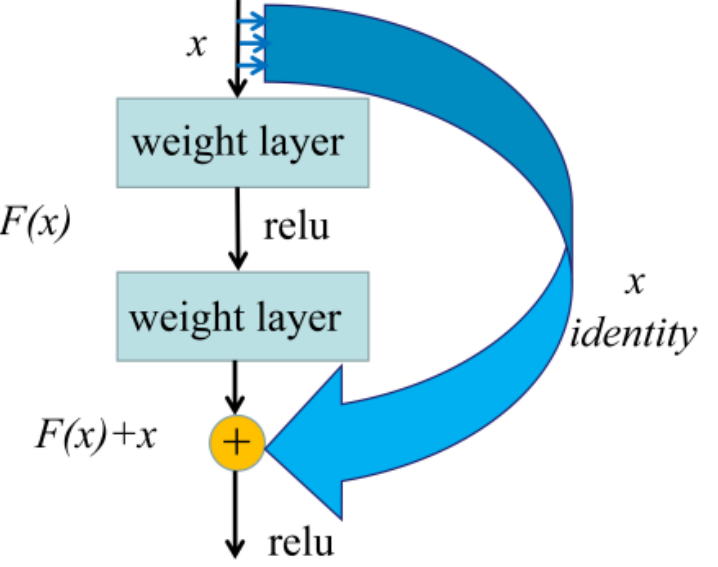
Figure 4. A diagram of ResNet50 residual learning.